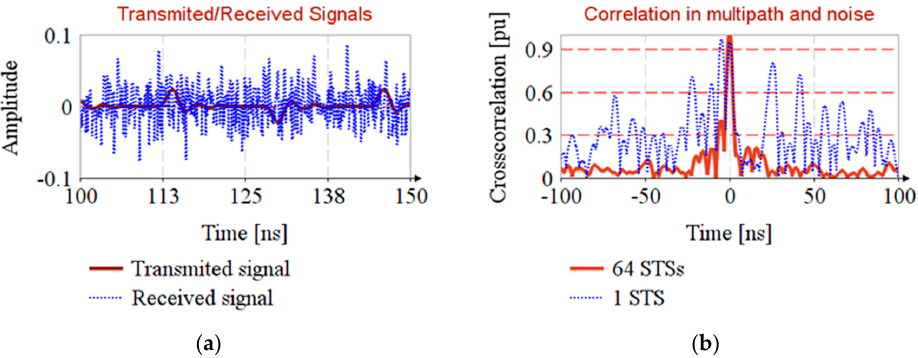
Figure 7. Timestamp estimation in noisy channel with multipath propagation.